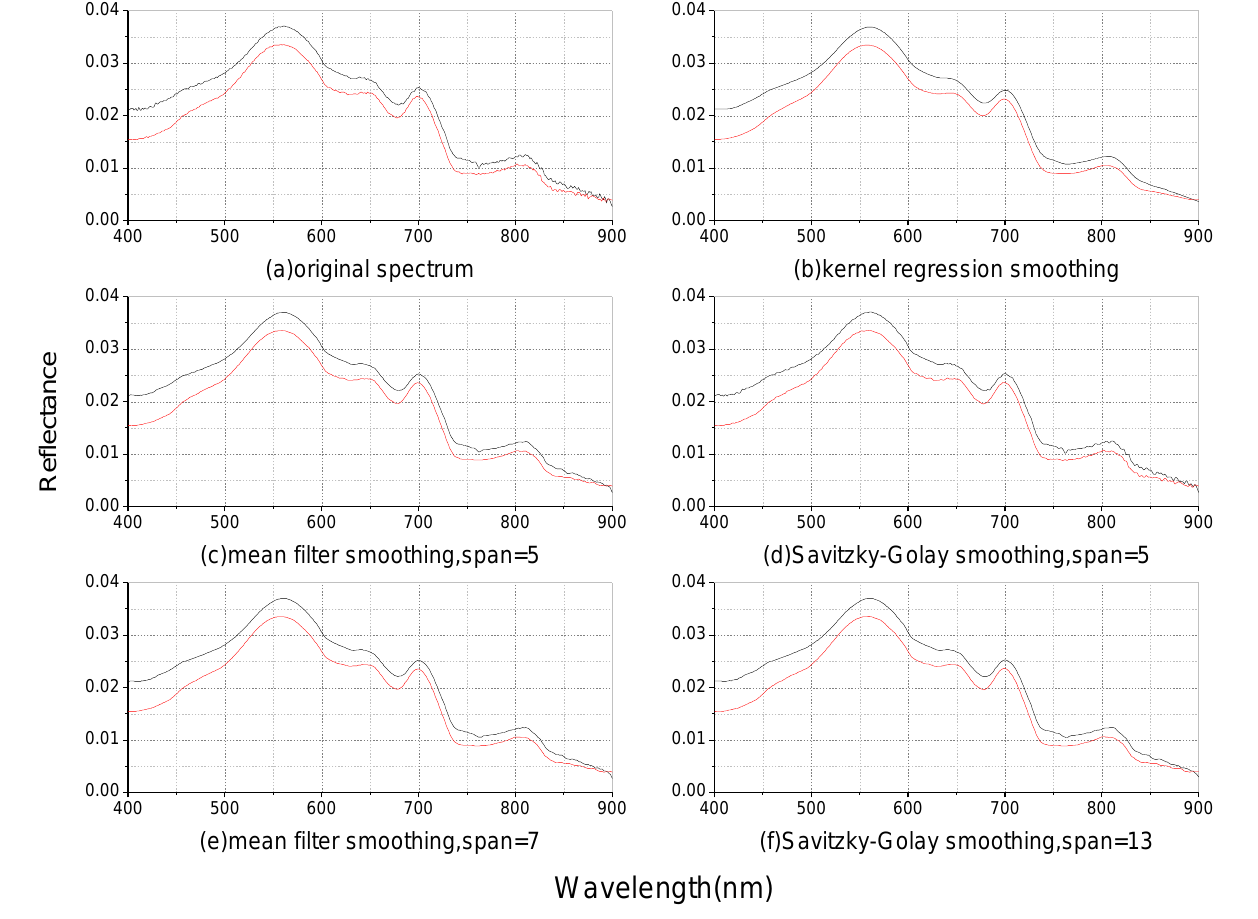
Figure 2. Spectrum reflectance ( a ) of the original spectra, ( b ) after kernel regression smoothing, ( c , e ) after mean filter smoothing, and ( d , f ) after Savitzky-Golay